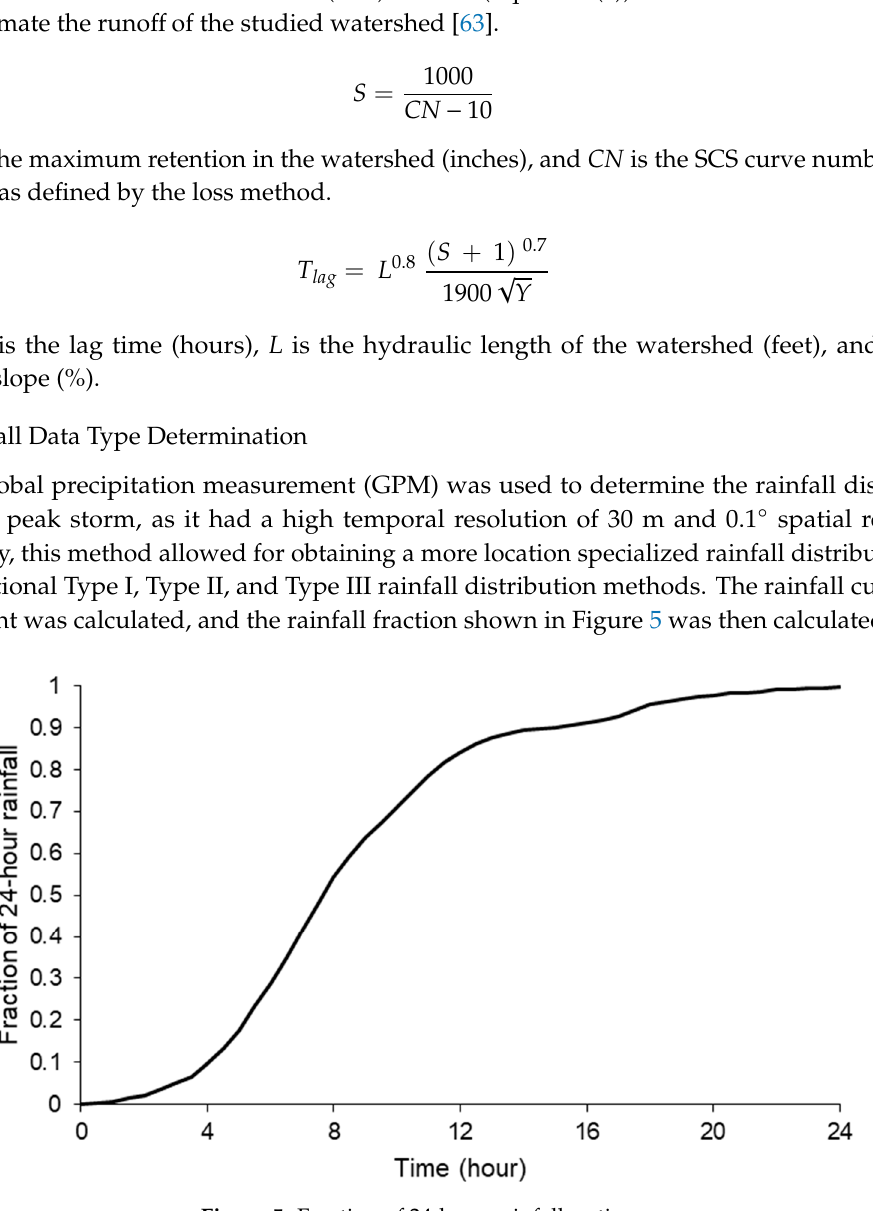
Figure 5. Fraction of 24-hour rainfall vs time.